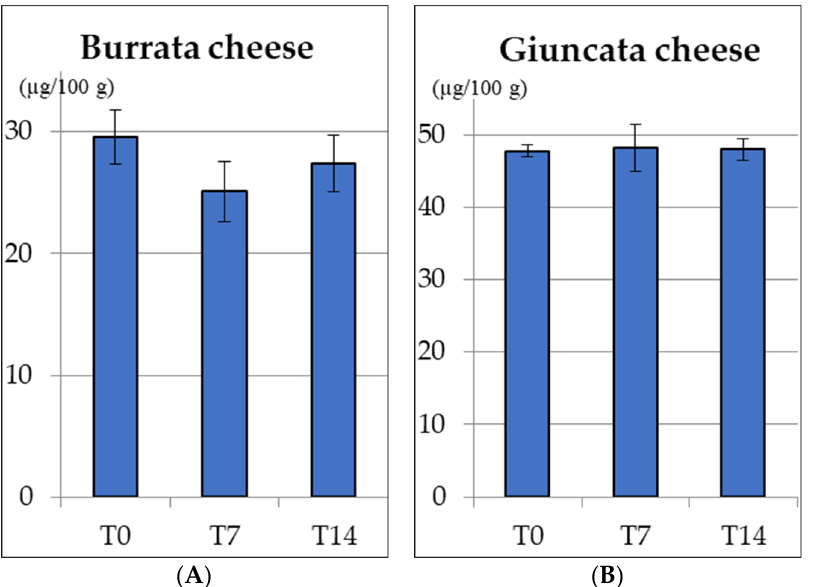
Figure 1. Stability of vitamin D 3 during storage burrata and giuncata cheeses (14 days at 4 °C). No statistical difference between the levels was found over the storage ( p < 0.05).